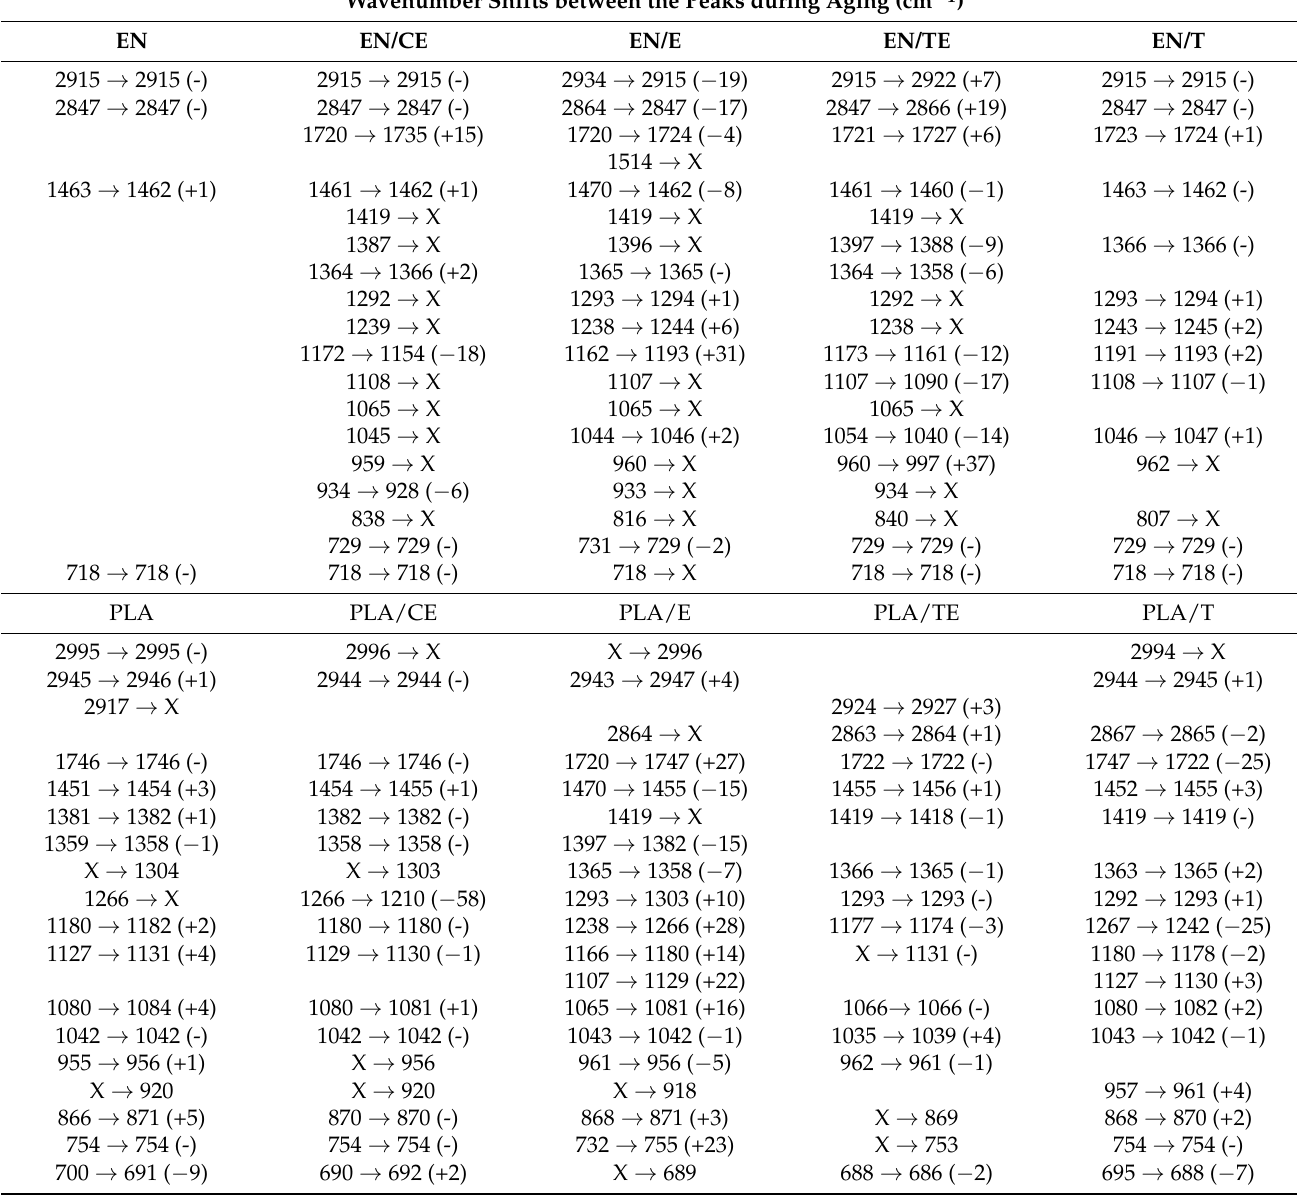
Table 4. Shifts in wavenumber observed during the solar aging process of unimpregnated and impregnated ethylene– norbornene copolymer and poly(lactic acid) specimens. Description: X 1 → X 2 ( ∆ X), where X 1 —initial wavenumber, X 2 —wavenumber assigned to the same peak after aging, ∆